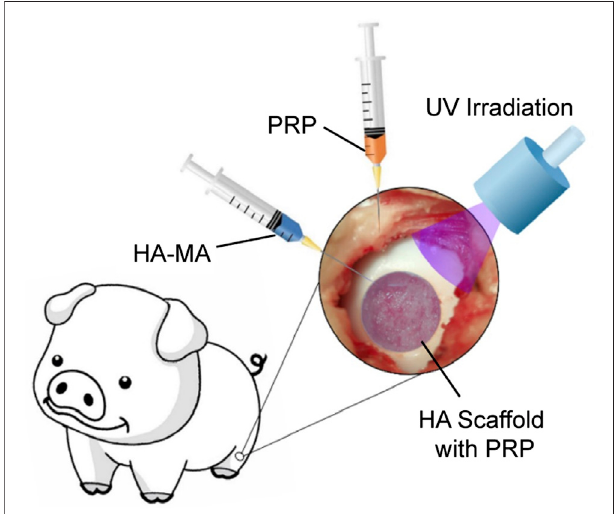
FIGURE 4 | Schematic of the surgical procedure for implantation of photo-cross-linked injectable scaffolds. Reproduced with permission from Yan et al.